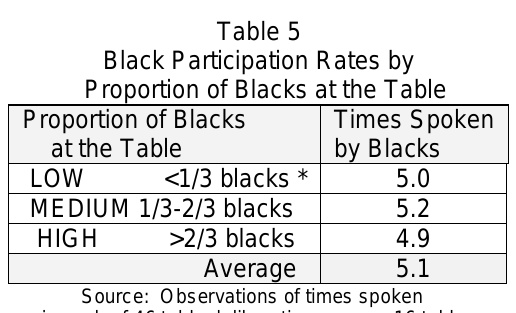
Source: Observations of times spoken in each of 46 table deliberations across 16 tables *Number of deliberations observed not